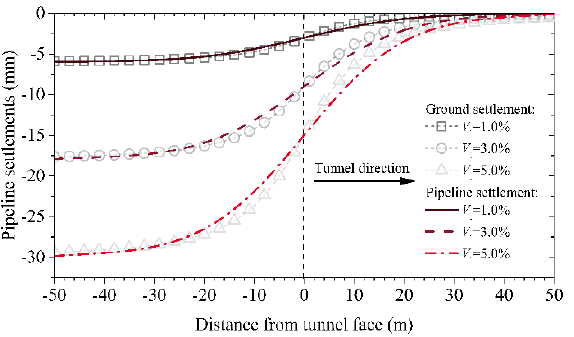
Figure 12. Longitudinal profiles of pipeline’s deformation with different ground volume losses.